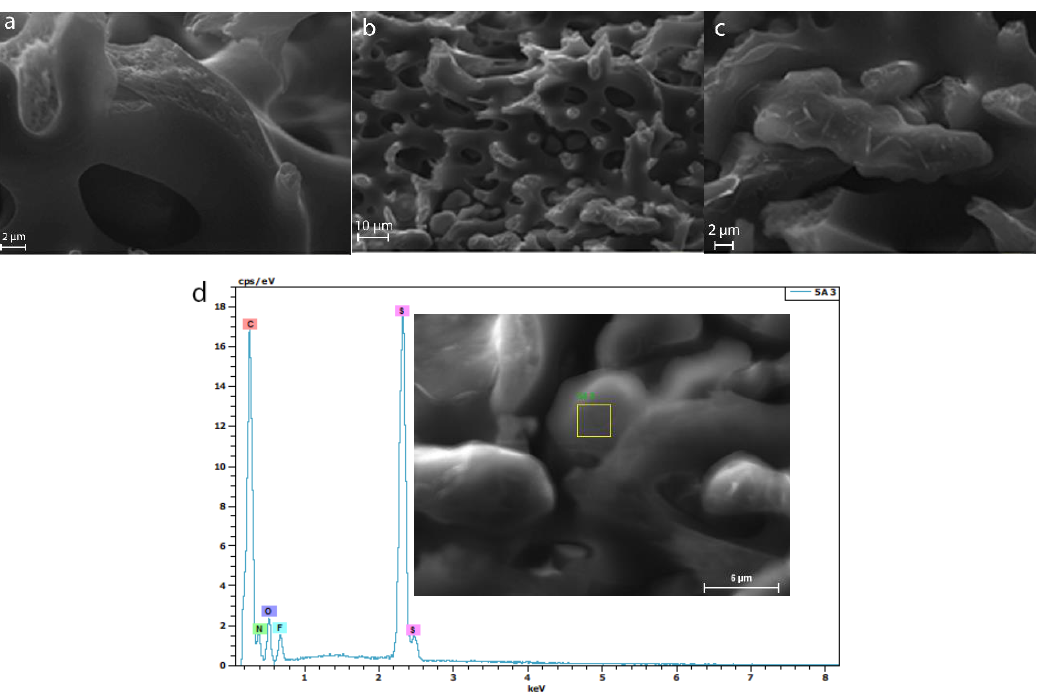
Figure 5. SEM images of ( a ) Matrimid ® , ( b , c ) Matrimid ® /VImTf membranes and ( d ) EDX spectrum of Matrimid ® /VImTf